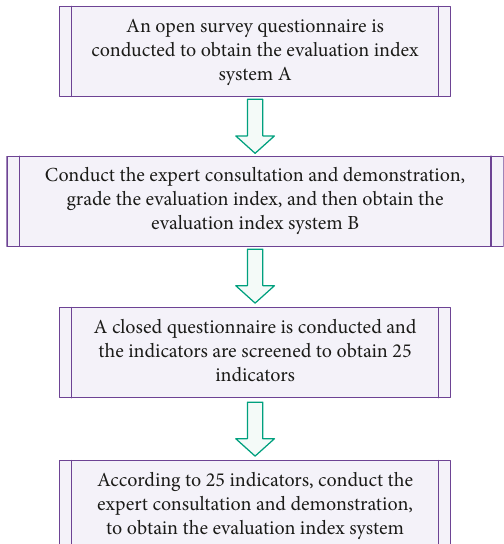
Figure 3: Flowchart of the construction index of tourism environmental carrying capacity.